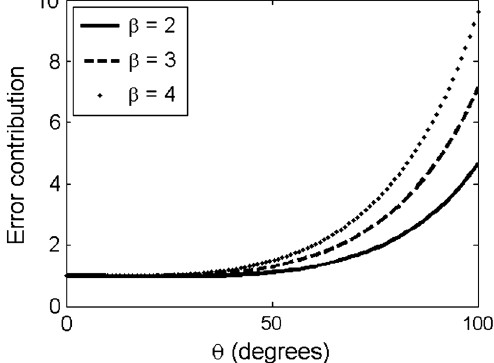
FIG. 7. Relative error contribution from the angle to the wakefield density measurement for various values of β ≡ ω 2 r 2 = 2 c 2 in Eq. p p